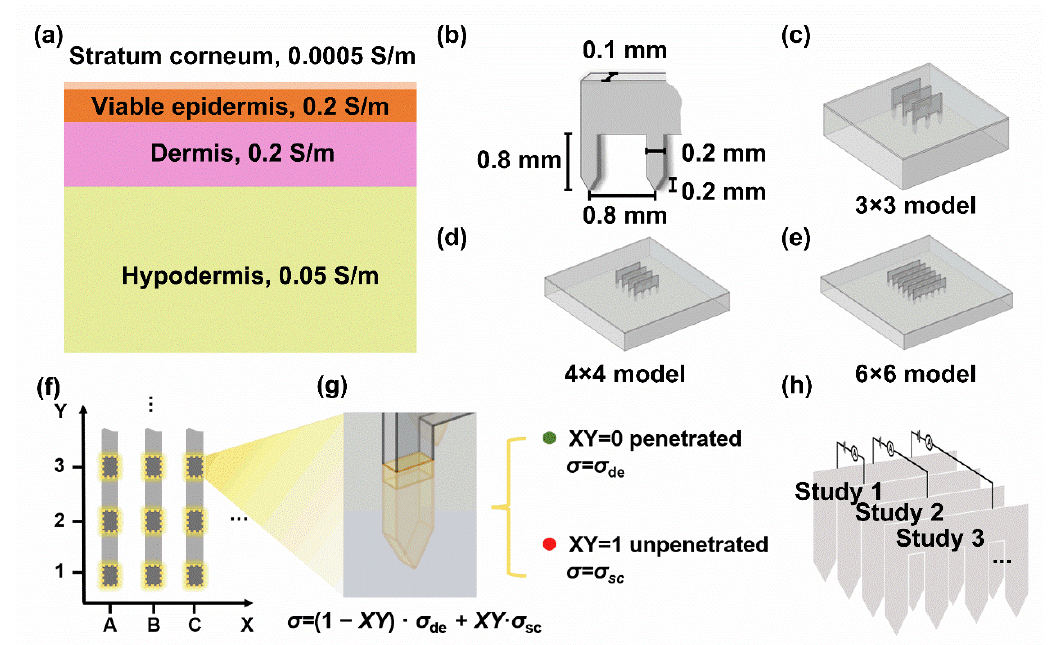
Figure 3. Schematic of the simulation model of metallic microneedle sheet array penetrating into the skin. ( a ) The anatomy of the skin and its electrical properties. The top to the bottom of the schematic represents the skin from the outside to the inside, involving stratum corneum, viable epidermis, dermis, and hypodermis, respectively. ( b ) Geometric sketch of the tip of the metallic microneedle sheet array. ( c – e ) Geometric sketch of 3 × 3, 4 × 4, and 6 × 6 metallic microneedle sheet array model. The distance between two microneedle sheet was 0.8 mm. ( f ) Diagram of the numbering of microneedle sheets and tips. The microneedle sheets were numbered by A, B, C, and so on. The tips on the microneedle sheet were numbered by 1, 2, 3, and so on. ( g ) Schematic of the tip – skin interface physic setting. The boundaries between tip and skin (highlighted by yellow) were set as contact impedance with 20 μm extra physical thickness. The conductivity of these boundaries was depended on the transdermal condition. ( h ) Schematic of the inter-sheet current study. The simulation results were obtained by the inter-sheet current study in pairs.